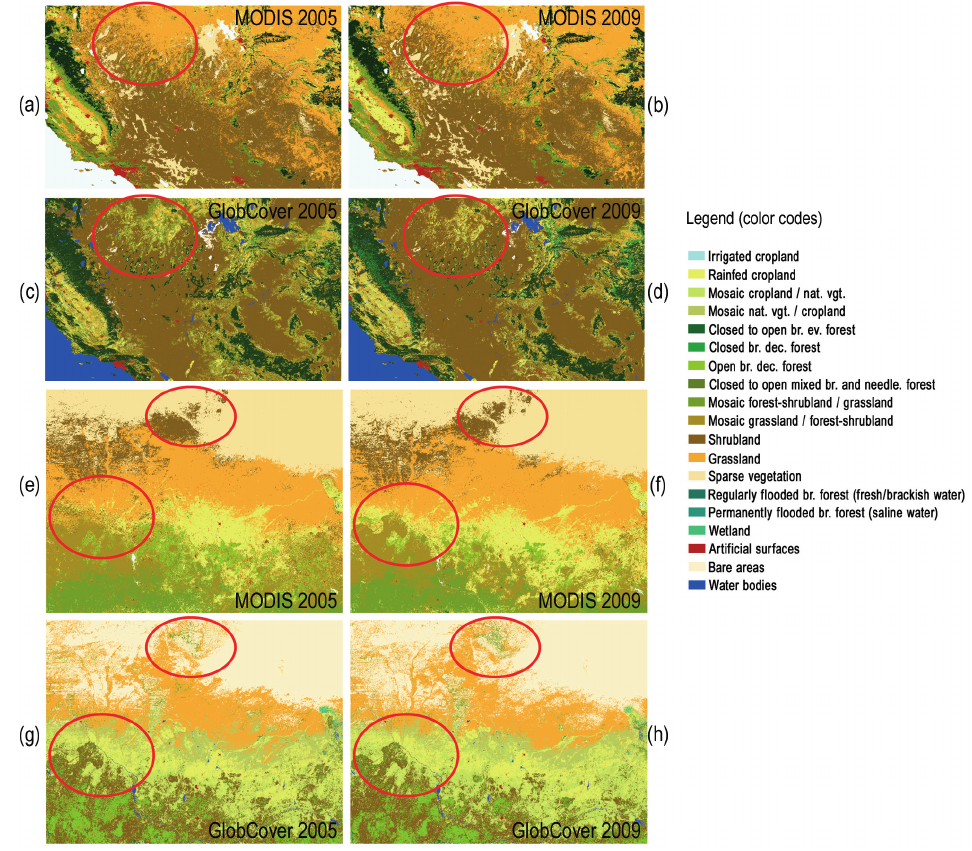
Fig. 3. Illustrations over United States ( a to d ) and Africa ( e to h ) showing the existence of spurious inter-annual variability between successive